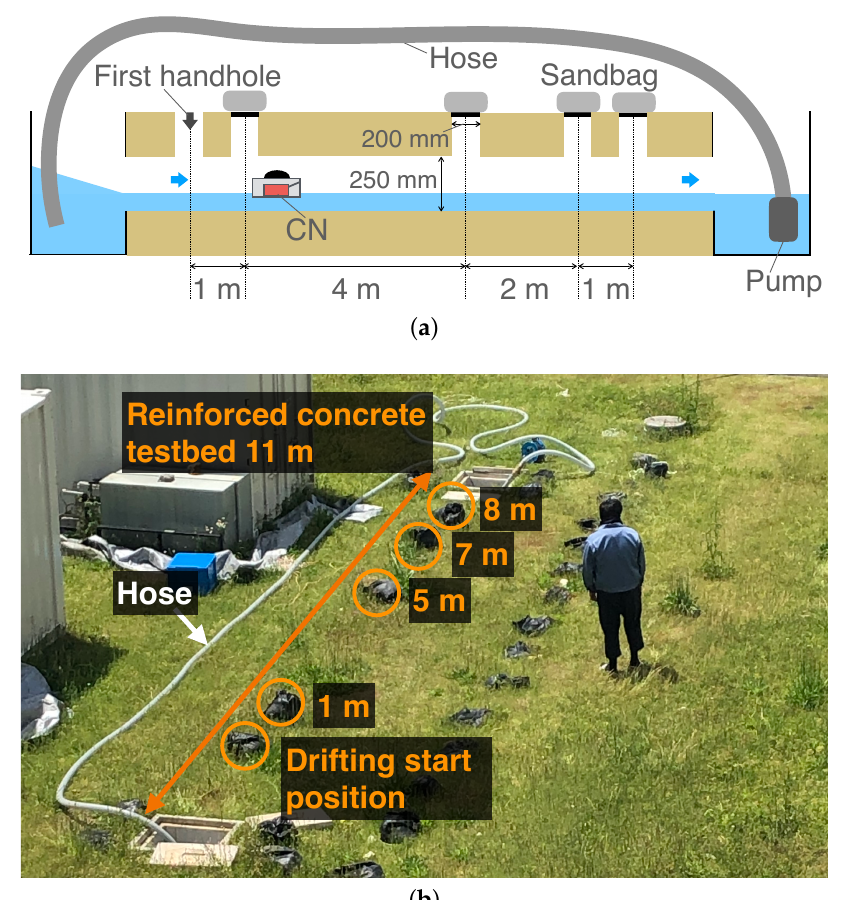
Figure 10. Overview of the testbed. ( a ) Structure; ( b )